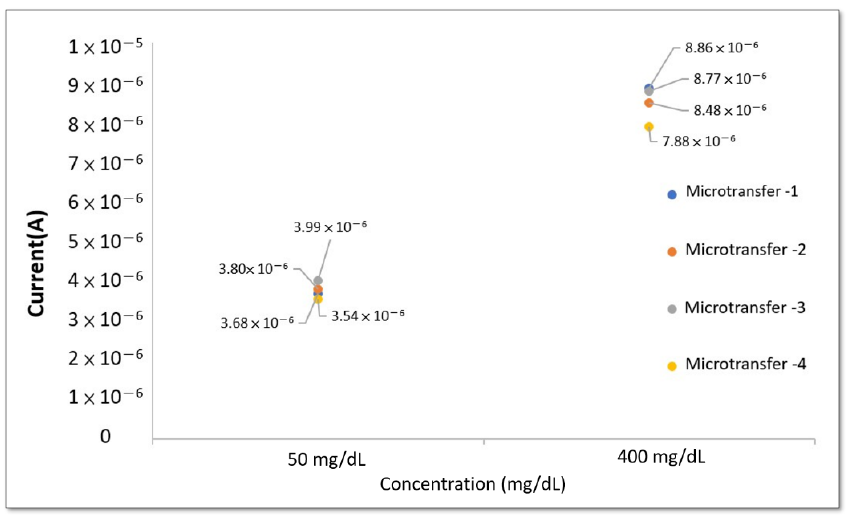
Figure 10. The relationship between current and glucose concentration when the potential is 0.65 V during the continuous transfer of 10 strips of working electrodes.